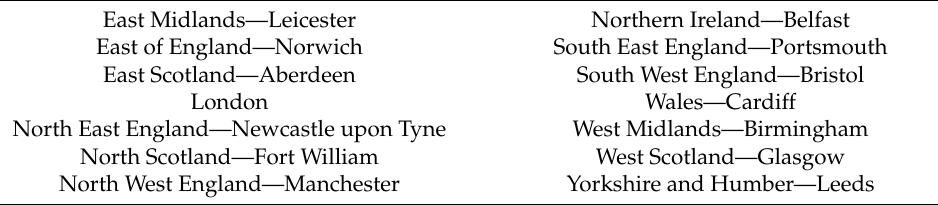
Table 4. List of UK regions and weather